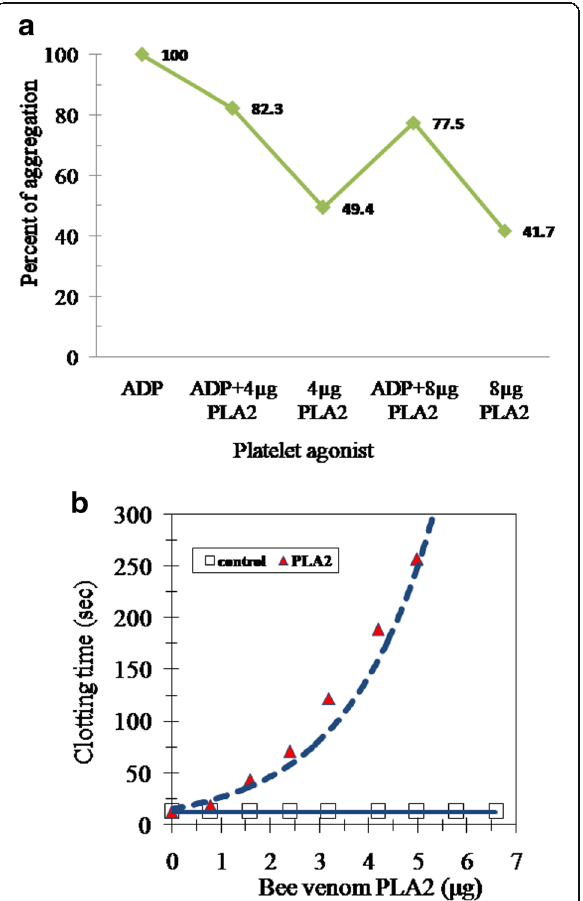
Fig. 4 a Anti-platelet aggregation effect of bee venom PLA2. b The anti-clotting activity of bee venom